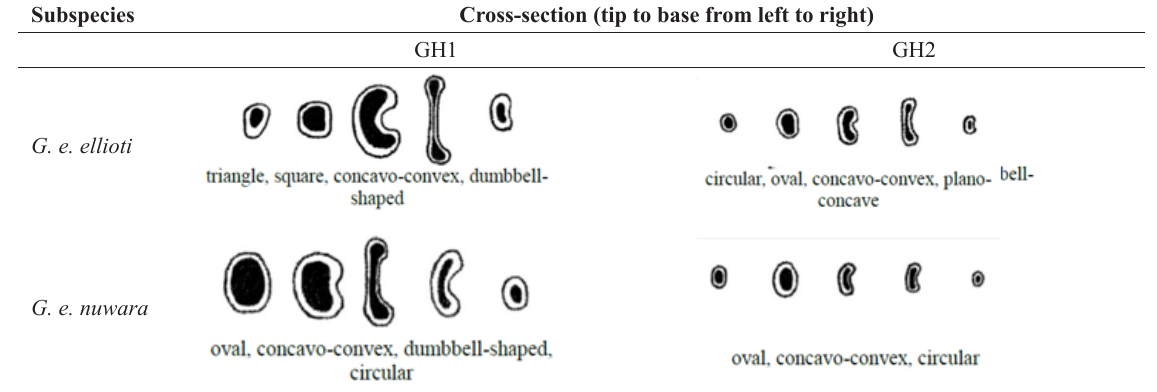
Figure 1: Cross sections at the tip of shield of Guard Hair 1 (GH1) and Guard Hair 2 (GH2) of G. e. ellioti and that of G. e. nuwara (Niroshani and Meegaskumbura, 2015)